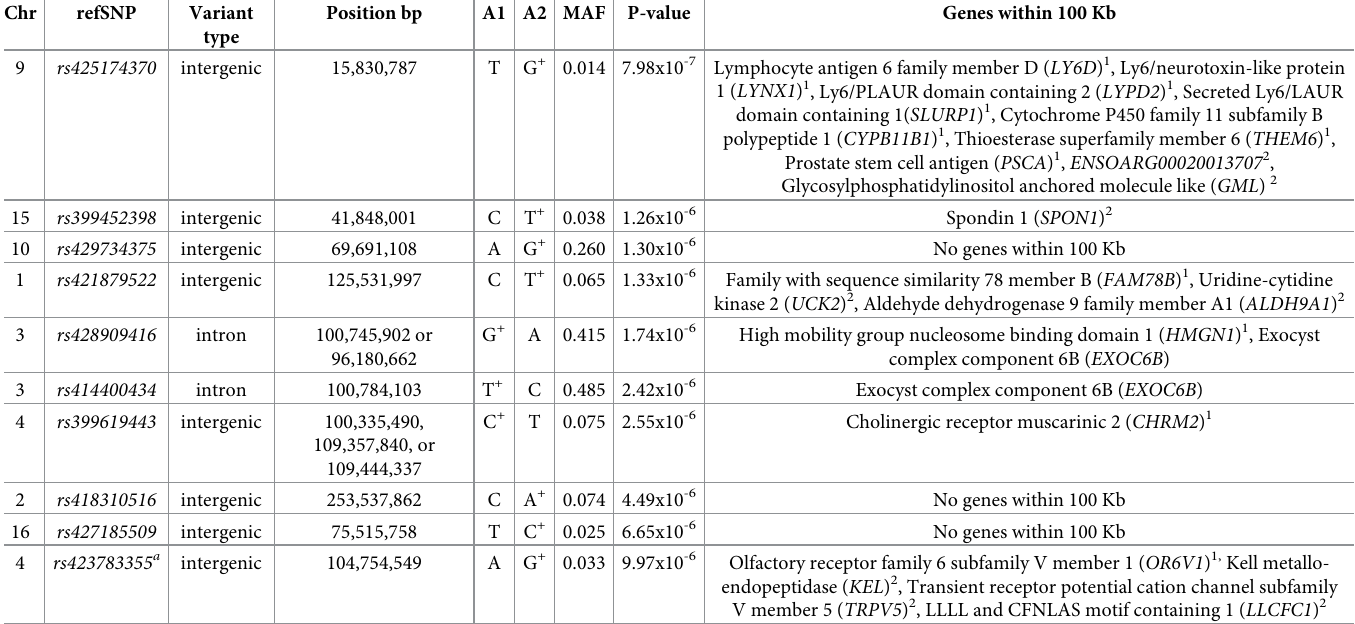
Table 2. Genome-wide suggestive single nucleotide polymorphisms (SNPs) associated with absolute monocyte count.